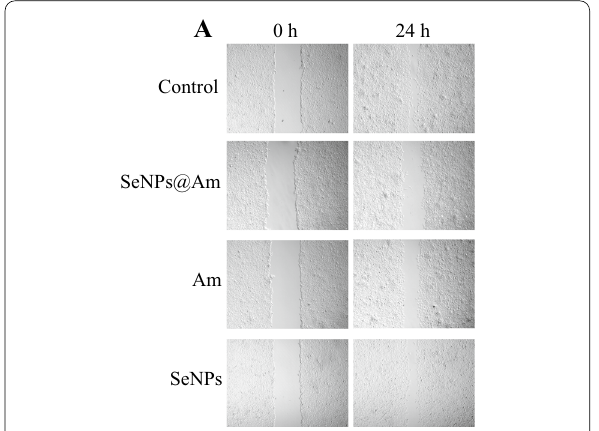
Fig. 9 Wound edges were marked with lines. Amplification, The wound-healing width was observed at the indicated time after the treatment of